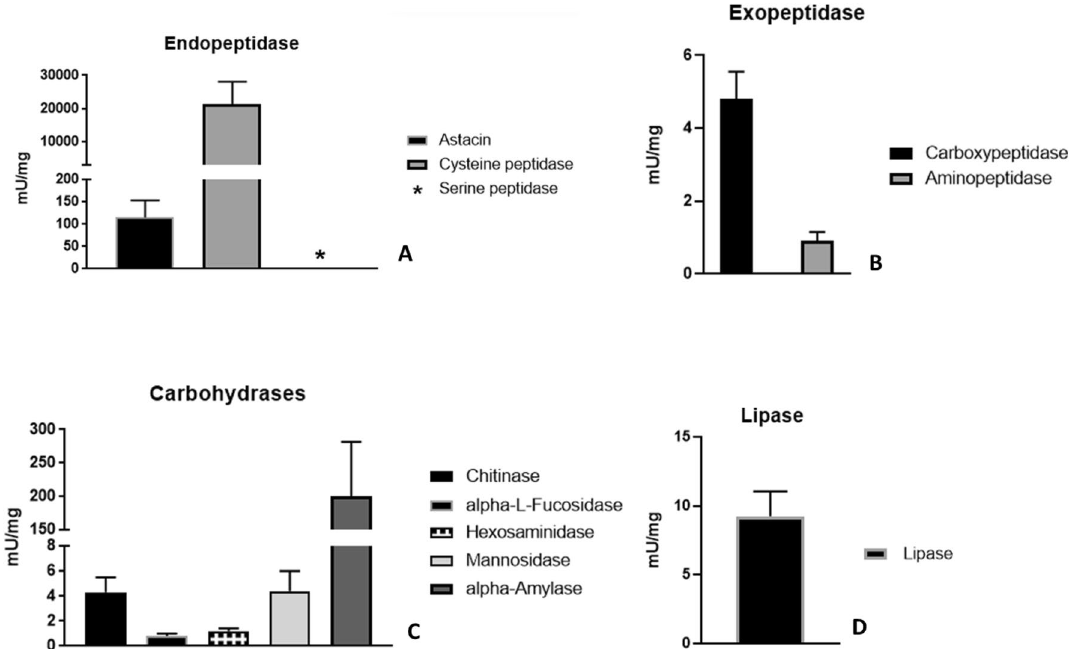
Figure 2. Values of endopeptidases, exopeptidases, carbohydrases and lipase specific activities from the midgut diverticula (MD) of Uloborus sp. Enzyme assays were performed as shown in Table 1. N = 5 to endopeptidases (2A); N = 6 to exopeptidases (2B); N = 8 to carbohydrases (2C), except to alpha-amylase (N = 4) and N = 8 to lipase (2D). Colored bars represent specific activity, mean and ± standard deviation of biological replicates for a specific enzyme according to color legend. * Means no activity